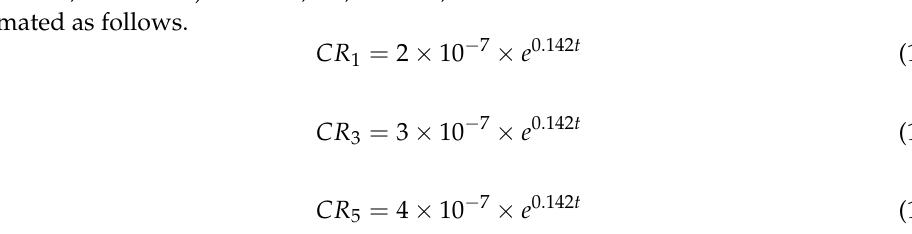
where, CR 1 , CR 3 , and CR 5 are the cancer risk associated with the first, third, and fifth showering events, and t is the showering duration